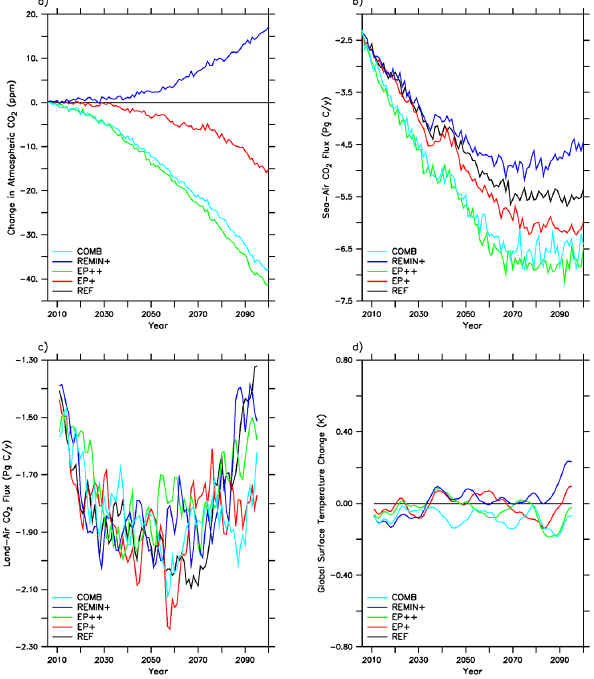
Figure 4. (a) Change in atmospheric CO 2 (ppm) for the future pe- riod relative to the REF simulation for the various OA experiments (see Table 2 for a description of the experiments). (b) Simulated global ocean carbon uptake for the different OA experiments. (c) Simulated 10-year running mean of the land carbon uptake by the different OA experiments. (d) Simulated 10-year running mean of the change in global surface temperature relative to the REF simu- lation for the various OA experiments.